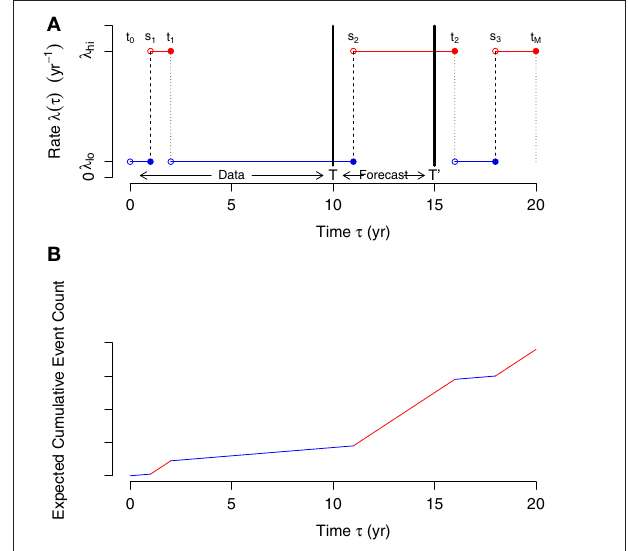
FIGURE 4 | Simulated rate function λ ( τ ) of PDCs in top panel (A) and, in bottom panel (B) , expected cumulative event count τ τ j τ ] E [ # of PDCs at times 0 0 λ ( t ) dt , plotted against time τ since ≤ ≤ = eruption onset. Observation period [0, T ] and forecast period ( T , T ′ ] are R indicated, with T 10 year and T ′ 15 year. Compare to observed = = cumulative event counts in Figure 3 .